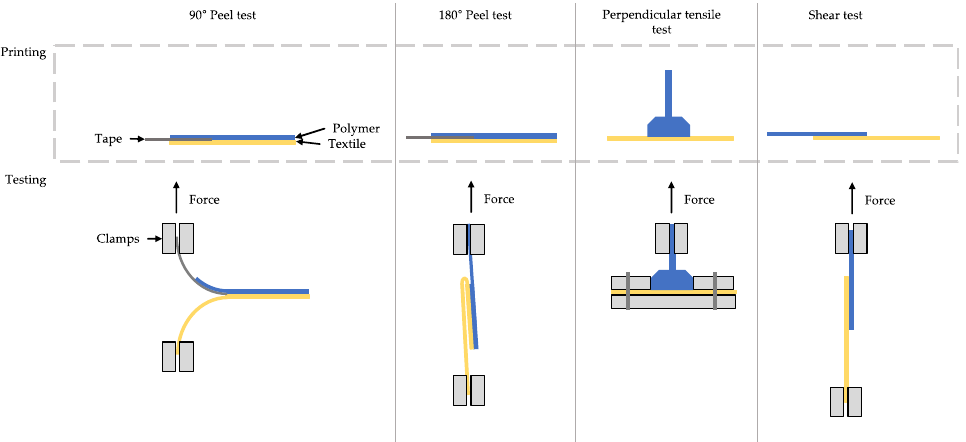
Figure 8. Current testing methods for 4D textiles: 90° peel test, 180° peel test, perpendicular tensile test and shear test. test and shear